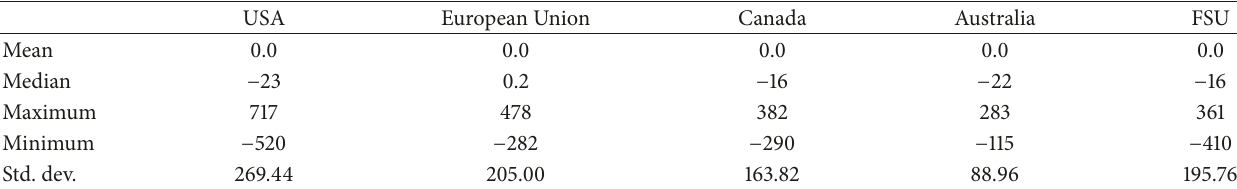
Table 4: Summary of precipitation statistics in +/ − from average (mm).